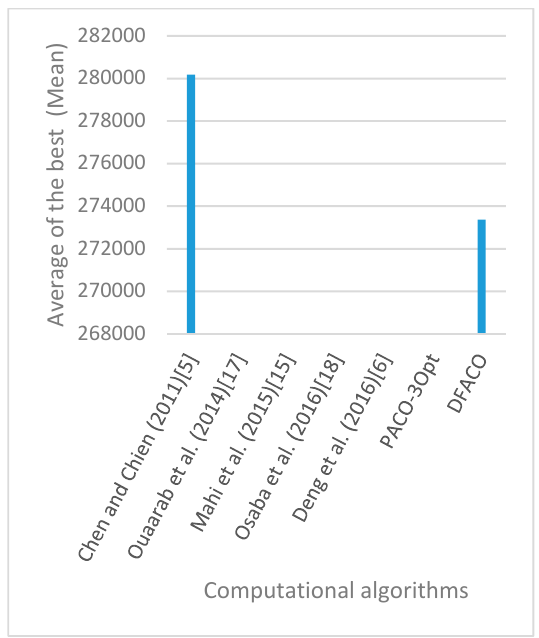
Figure 29. Average of best solutions obtained for instance rl1323 by all algorithms.